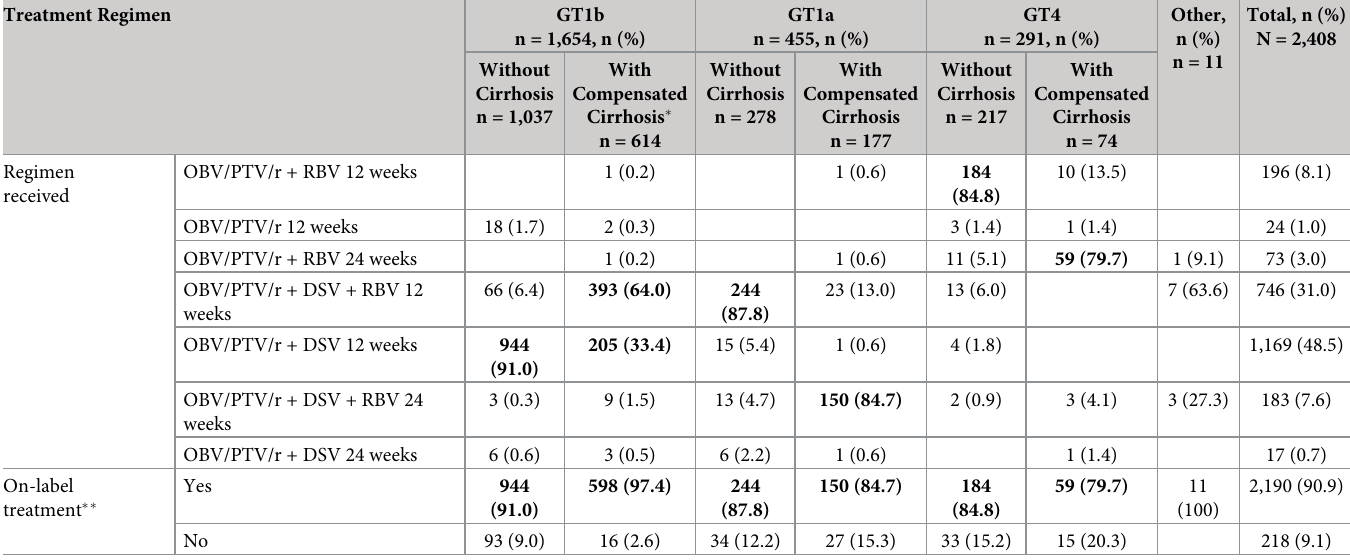
Table 2. Selected treatment